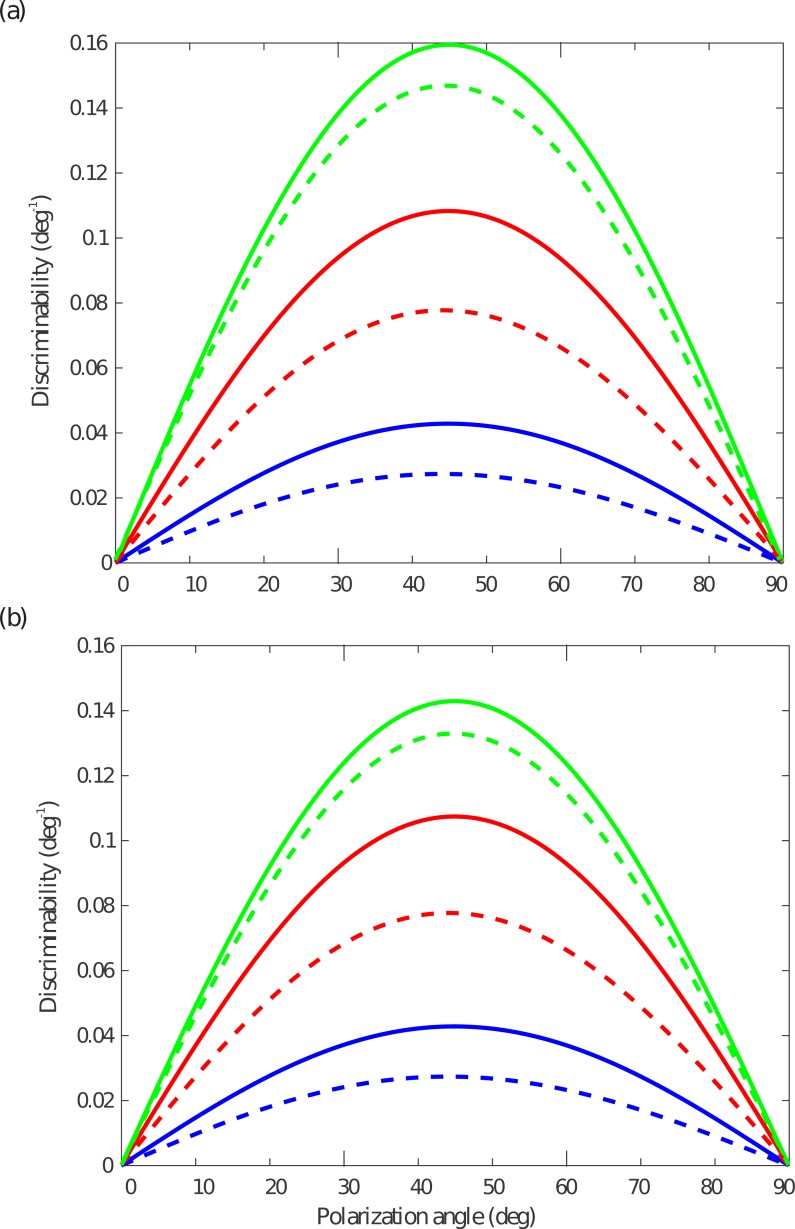
Discriminability as a function of polarization angle, θ, for light with degree of polarization d = 0.1, at three incident photon fluxes, Ni.(A) Rhabdom length l =100 µm with R7 and R8 of the same length, \documentclass[12pt]{minimal}
\usepackage{amsmath}
\usepackage{wasysym}
\usepackage{amsfonts}
\usepackage{amssymb}
\usepackage{amsbsy}
\usepackage{upgreek}
\usepackage{mathrsfs}
\setlength{\oddsidemargin}{-69pt}
\begin{document}
}{}$\hat {{l}_{8}}=0.5$\end{document}l8 ˆ=0.5 (continuous lines) and with shorter R8, \documentclass[12pt]{minimal}
\usepackage{amsmath}
\usepackage{wasysym}
\usepackage{amsfonts}
\usepackage{amssymb}
\usepackage{amsbsy}
\usepackage{upgreek}
\usepackage{mathrsfs}
\setlength{\oddsidemargin}{-69pt}
\begin{document}
}{}$\hat {{l}_{8}}=0.1$\end{document}l8 ˆ=0.1 (dashed lines). (B) As (a), but taking into account tranduction unit saturation. Incident photon flux, Ni: 1 × 105 (blue), 3 × 105 (red), and 1 × 106 (green) photons s−1.